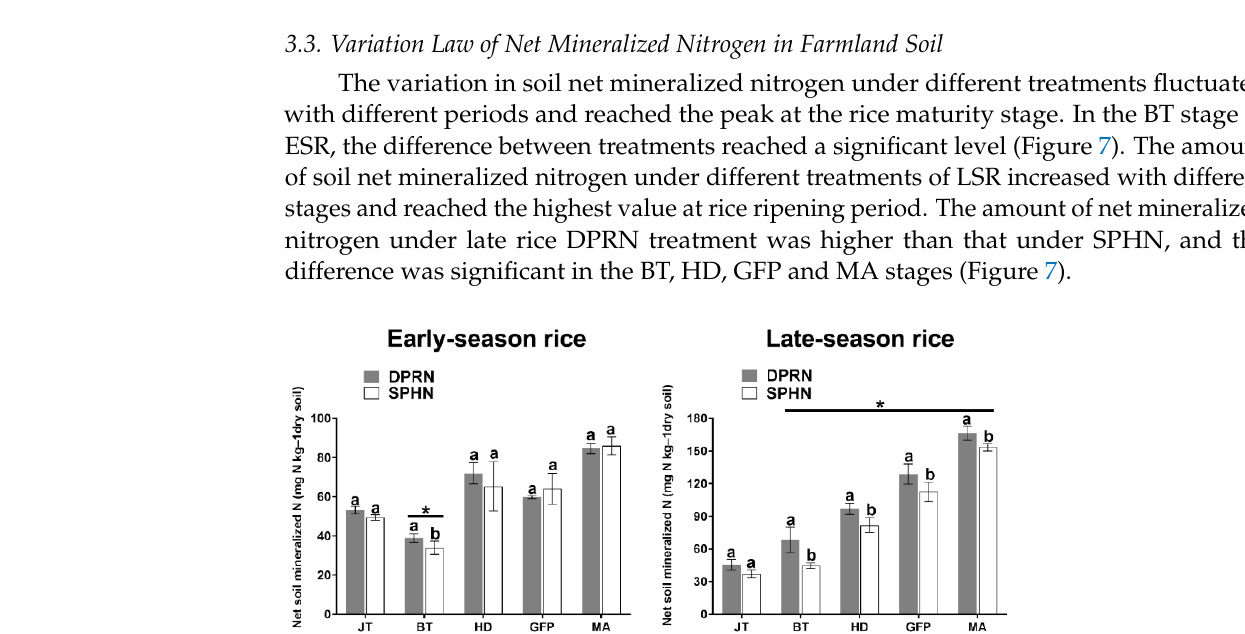
Figure 7. Net soil mineralized nitrogen cultured for two weeks at different stages of double cropping rice under different treatments. Data points represent treatment means ( n = 3), and different letters indicate significant differences (* p < 0.05). DPRN represents dense planting with a reduced nitrogen rate; SPHN represents sparse planting with a high nitrogen rate; JT represents the jointing stage; BT represent the booting stage; HD represents the heading stage; GFP represents the grain-filling period; MA represents the maturity stage.